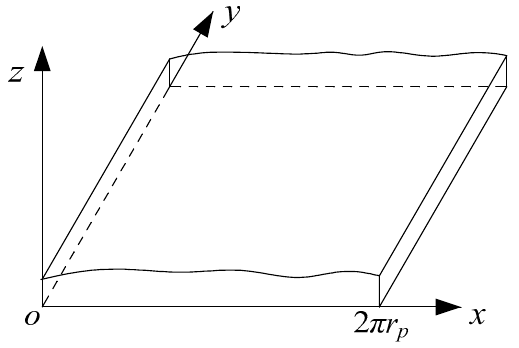
Figure 4. Piston pairs oil film unfolding diagram.